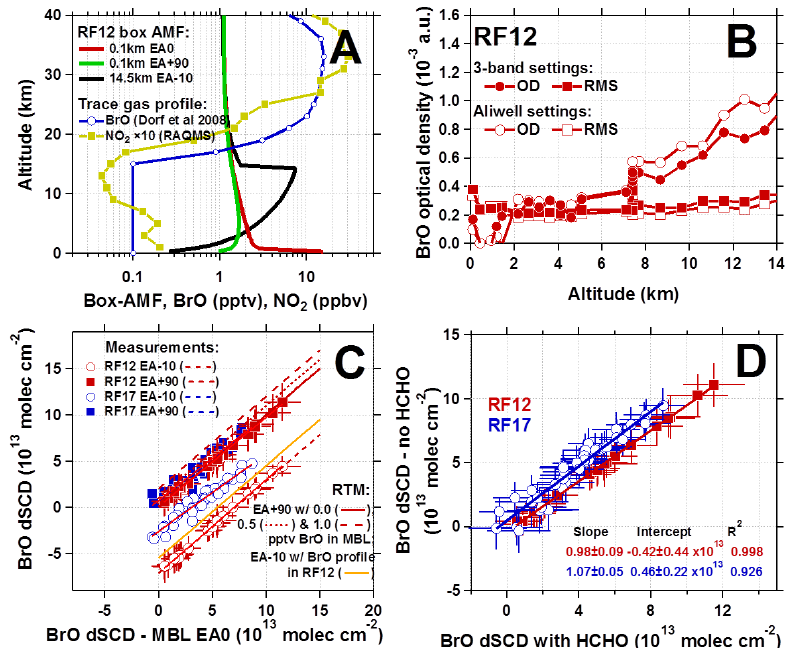
Figure 5. Assessment of the robustness of BrO dSCDs. (a) Box-AMFs for different geometries of reference spectra used during spectral fitting to derive dSCDs; a generic profile for BrO in the tropics and the NO 2 profile from the RF12 case study are also shown for comparison. (b) Signal-to-noise ratio for BrO detection as a function of altitude and comparison of the three-band BrO analysis window with fit settings of the two-band analysis of Aliwell et al. (2002). (c) Consistency of the intrinsic offset between dSCDs with RTM (see Sect. 3.2.1 for details). (d) Insensitivity of BrO dSCDs towards including or excluding a HCHO reference spectrum during